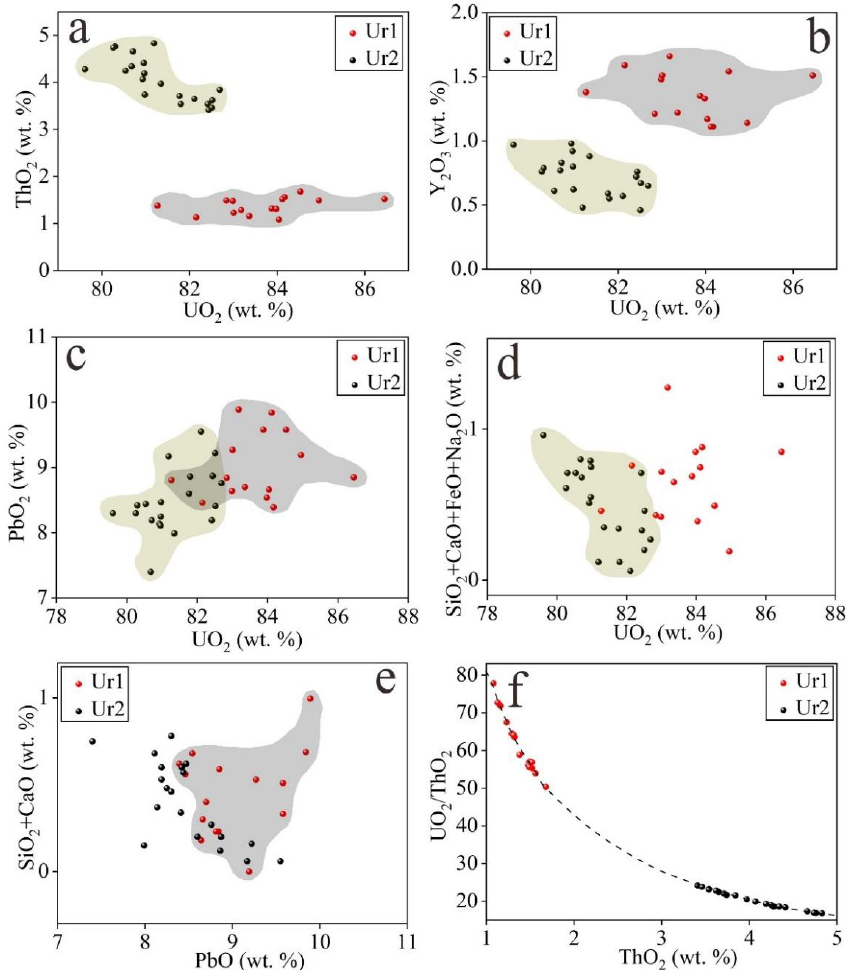
Figure 6. ( a – f ) Contents of the different major and minor elements in the Ur1 and Ur2 uraninite Figure grains.